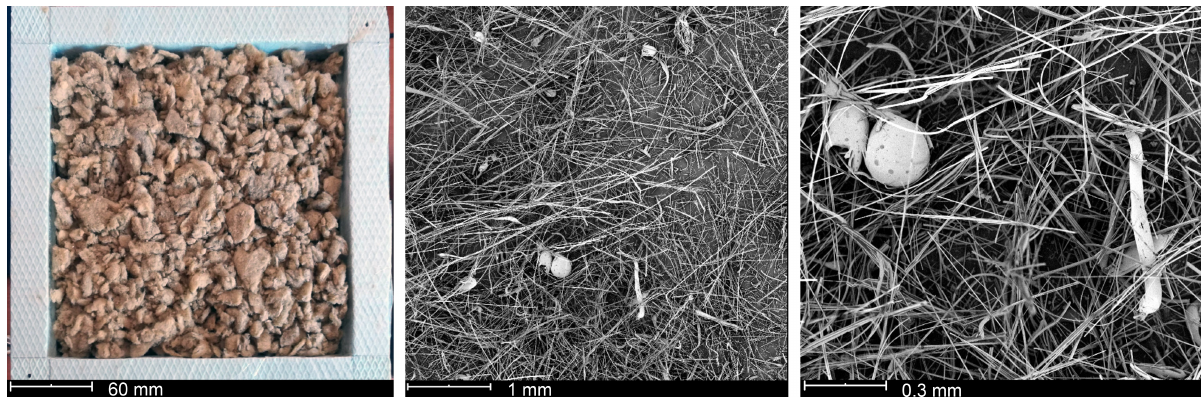
Figure 4. Representative optical and SEM images of micro-milled mineral wool waste (set B).